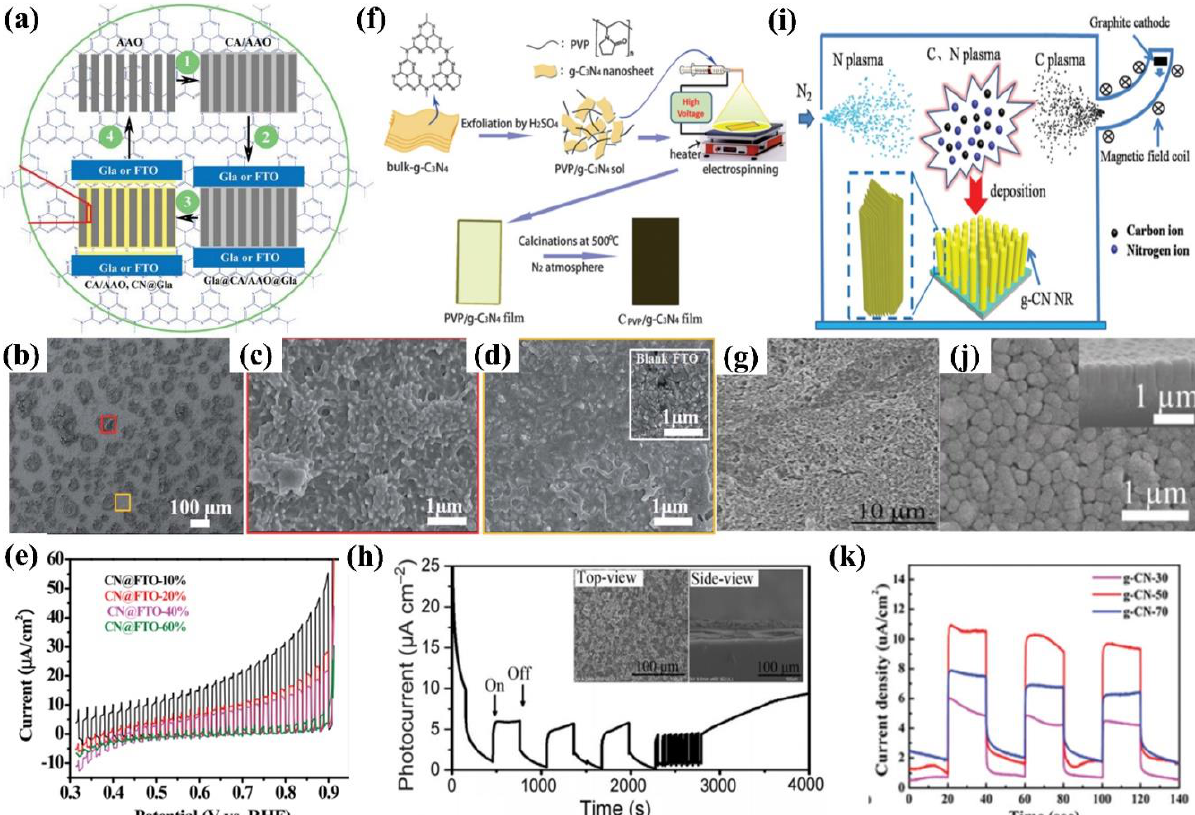
Figure 8. ( a ) Schematic illustration of printing g−CN thin films on “sandwiching” substrates (AAO template growth mechanism), ( b ) the surface morphology, ( c ) magnified image of the selected box area (red) in ( b ) displaying that the nano − islands, ( d ) magnified image of the selected box area (yellow) in ( b ) displaying the detailed microstructures (the inset is the bare FTO image), and ( e ) LSV photocurrent density in 0.2 M Na 2 SO 4 at 0.86 VRHE. Reprinted with permission from ref. [90] Copyright 2015 Wiley-Blackwell. ( f ) A diagram illustrating the process of